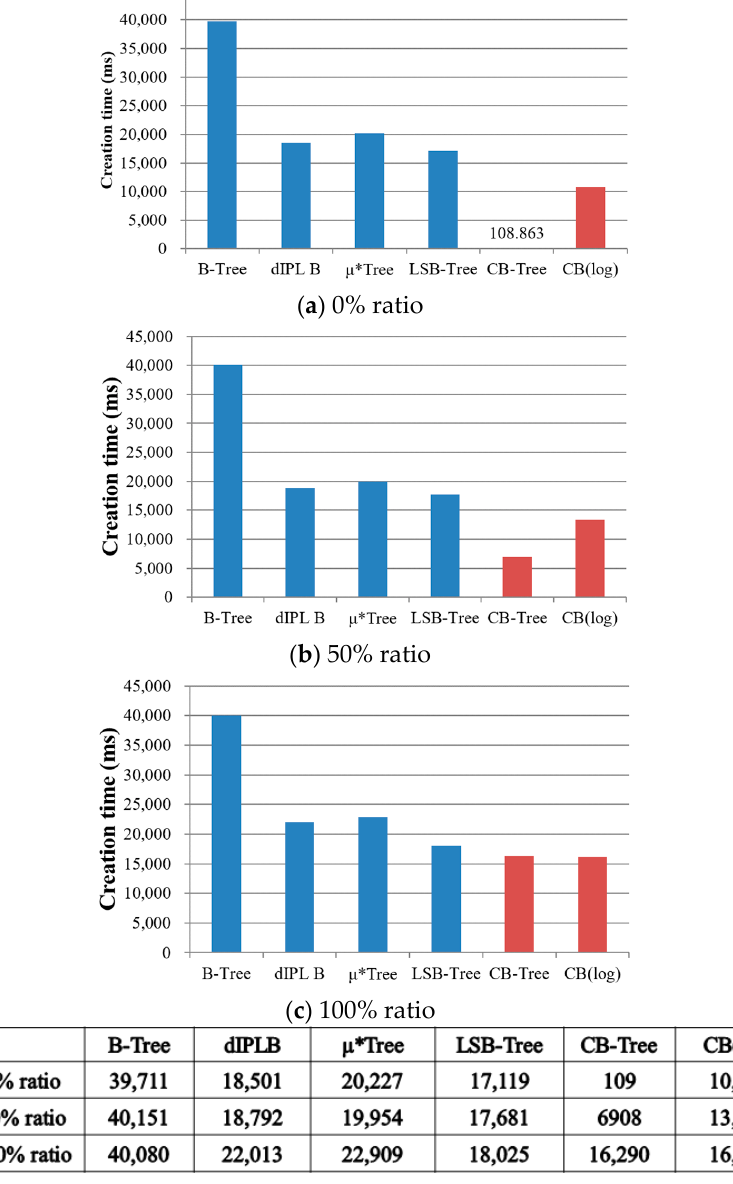
Figure 17. Creation time in structure-modified B-Trees.